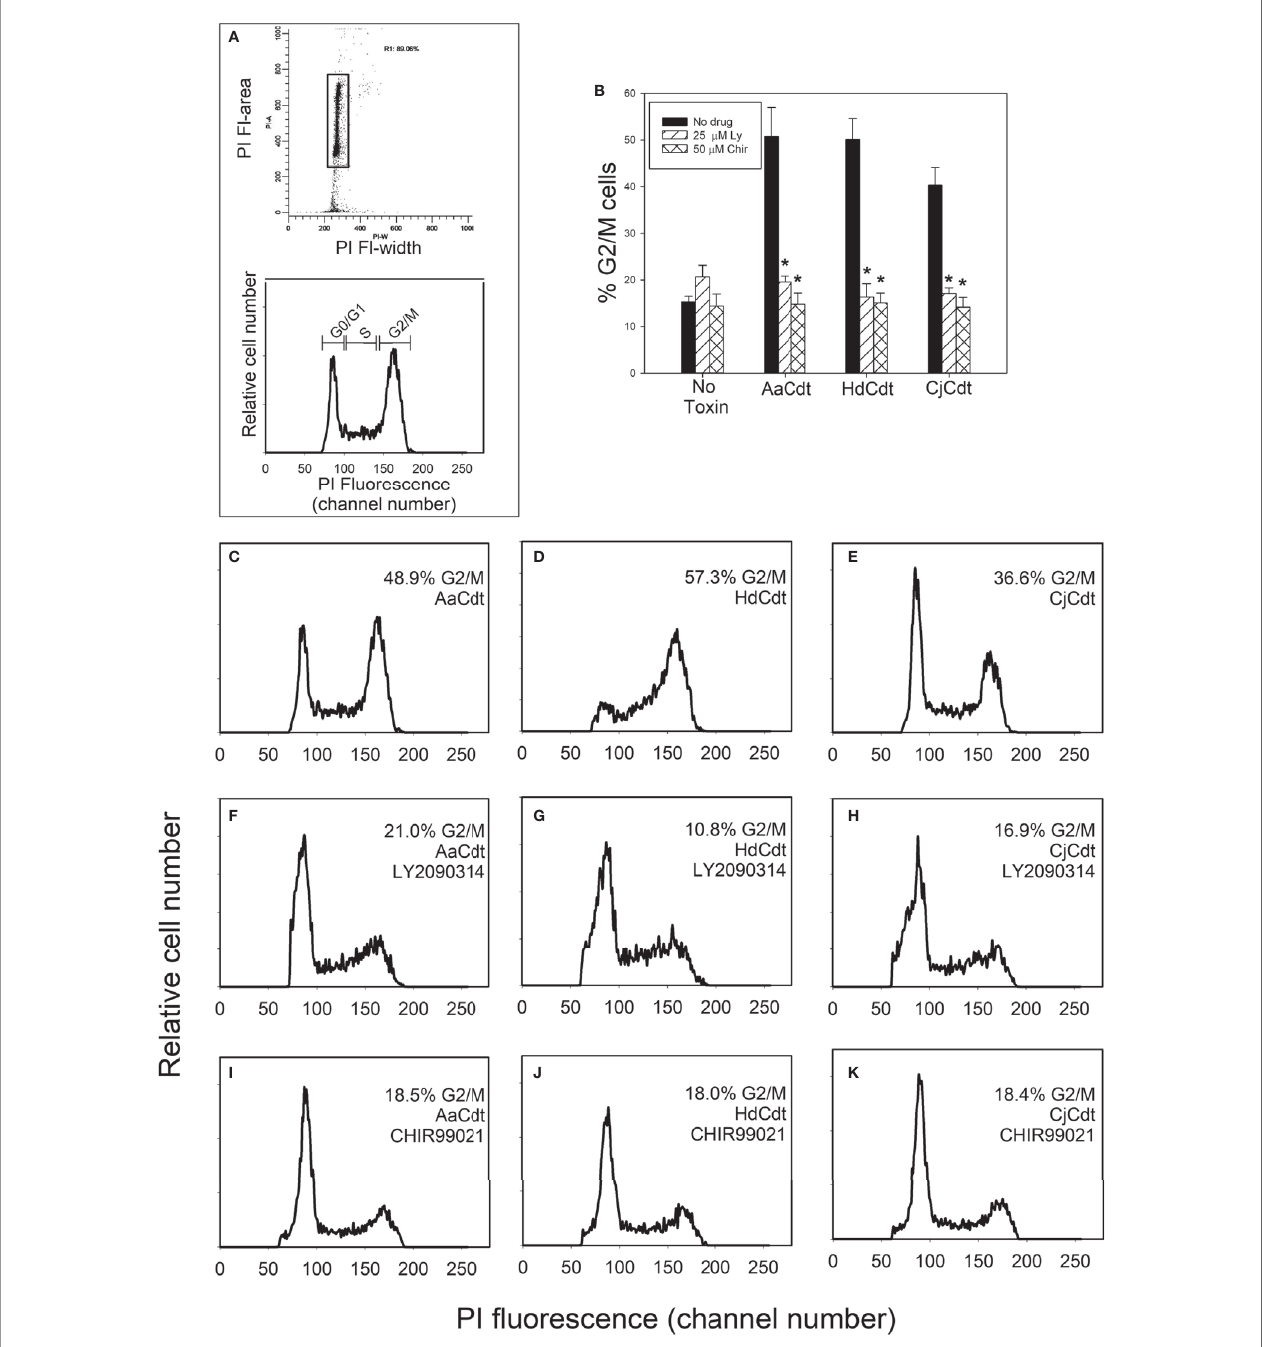
FIGURE 3 | Assessment of GSK3 b inhibitors for ability to block Cdt-induced cell cycle arrest. Jurkat cells were pre-treated with medium, 25 µM LY2090314, or 50 µM CHIR99021 for 1 hr followed by the addition of AaCdt (130 pM holotoxin), HdCdt (HdCdtA/C: 0.2 nM; HdCdtB: 0.3 nM) or CjCdt (CjCdtA/C: 1.0 nM; CjCdtB: 1.2 nM). Cells were harvested 24 hr later and analyzed for cell cycle distribution using propidium iodide and fl ow cytometry as described in Materials and Methods. (A) shows the gating strategy to identify cell cycle distribution. Debris and cell doublets were gated out using plots of propidium iodide fl uorescence area versus width (top panel; rectangle); analytical gates were set to identify cells in the G0/G1, S and G2/M phases of the cell cycle based upon propidium iodide fl uorescence (bottom panel). The percentage (mean ± SEM) of G2/M cells from three experiments, each performed in duplicate is shown in panel (B) ; *indicates statistical signi fi cance (p<0.01) when compared to cells treated with toxin alone. Representative histograms are presented from a single experiment: panel (C – E) show the results from cells pre-treated with medium only, panel (F – H) show results from cells pre-treated with LY2090314, and panel (I – K) show results from cells pre-treated with CHIR99021. Cells exposed to medium alone exhibited 15.3 ± 2.1% G2/M cells. Panels (C, F, I) were treated with AaCdt, panels (D, G, J) were treated with HdCdt and panels (E, J, K) were treated with